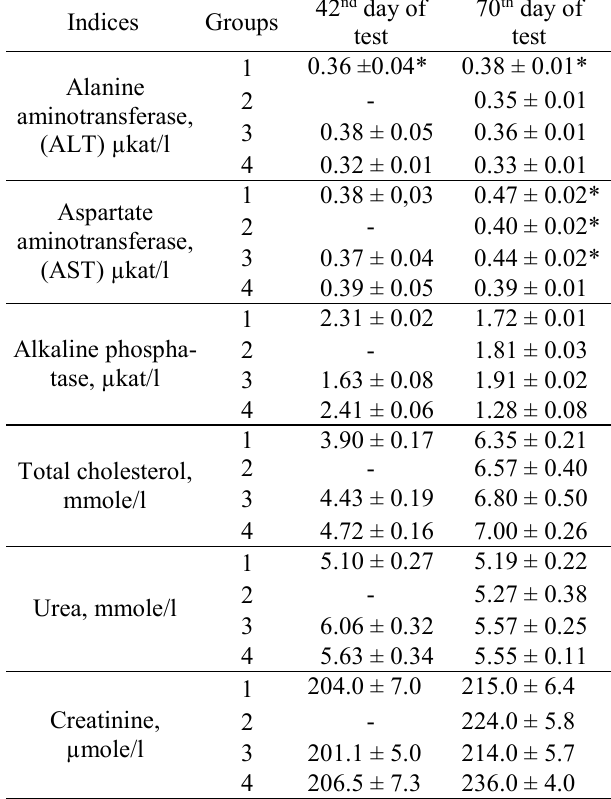
Biochemical indices of blood serum of piglets at application of probiotic feed additives (M ± m, n = 10)